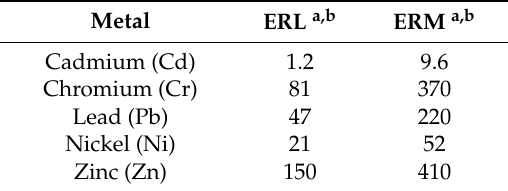
Table 6. ERL (effects range low) and ERM (effects range median) limits for